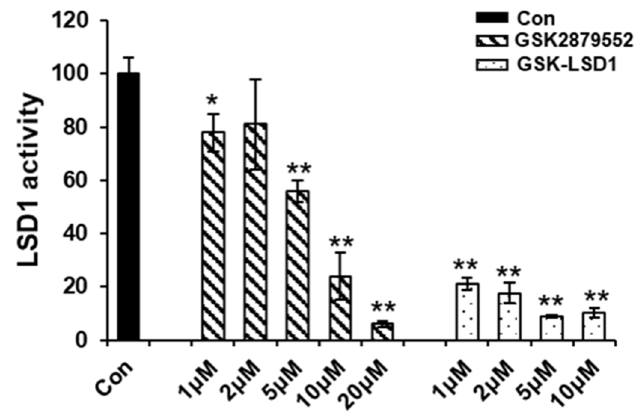
Figure 5. Effect of LSD1 inhibitor demethylation activity of LSD1. The effect of LSD1 inhibitors on LSD1 activity was determined by the LSD1 inhibitor screening kit. The data presented are the mean ± SD of three independent experiments. * p < 0.05; ** p < 0.01, compared with the control group.